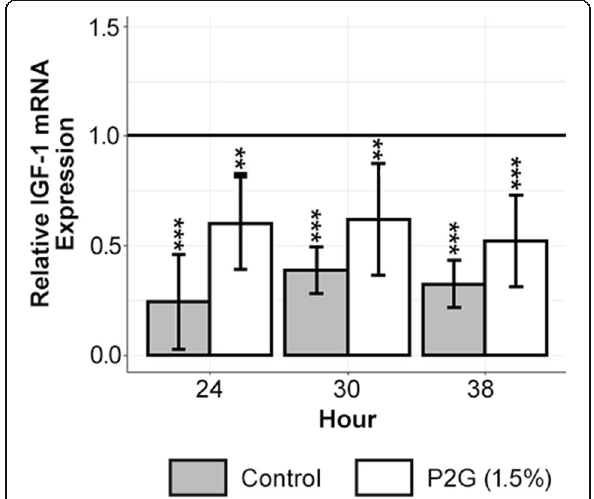
Fig. 2 Experimental data indicate that preosteoblasts ’ mean relative IGF- 1 expression at the pre-treatment baseline is higher than either P2G or water treated preosteoblasts ’ mean relative IGF-1 expression at each time point (regression with indicator variables). Experimental data indicate that treated preosteoblasts have a higher mean relative IGF-1 expression than water treated controls (fold increase of 1.82, two-way ANOVA that aggregates the three biological replicates from each time point into an overall study arm and as a consequence precisely estimates the standard error). Significance of each group, as shown with asterisks refers to comparison with the hour 0 control. The solid line is the normalized mean of hour 0 pre-treatment baseline measurements. Control refers to study arms treated with water. The graph displays qRT-PCR mRNA expression. NS p >0.05, * p <0.05, ** p <0.01, *** p